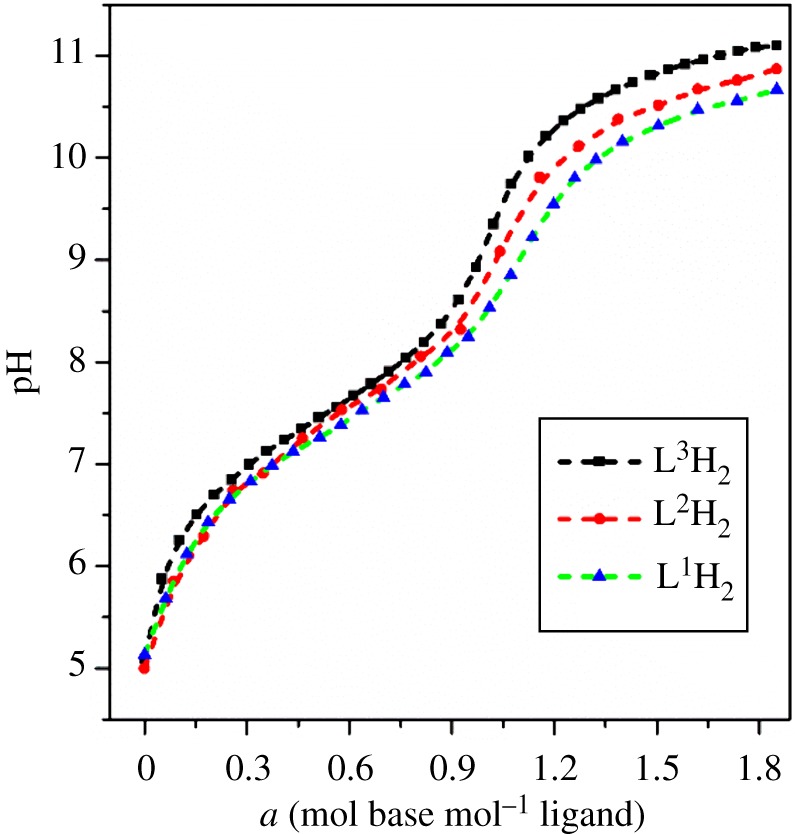
Potentiometric titration curves of L1-3H2, condition: [L1-3H2] = 5.0 × 10−4 M, µ = 0.10 M KCl, T = 298.2 K.